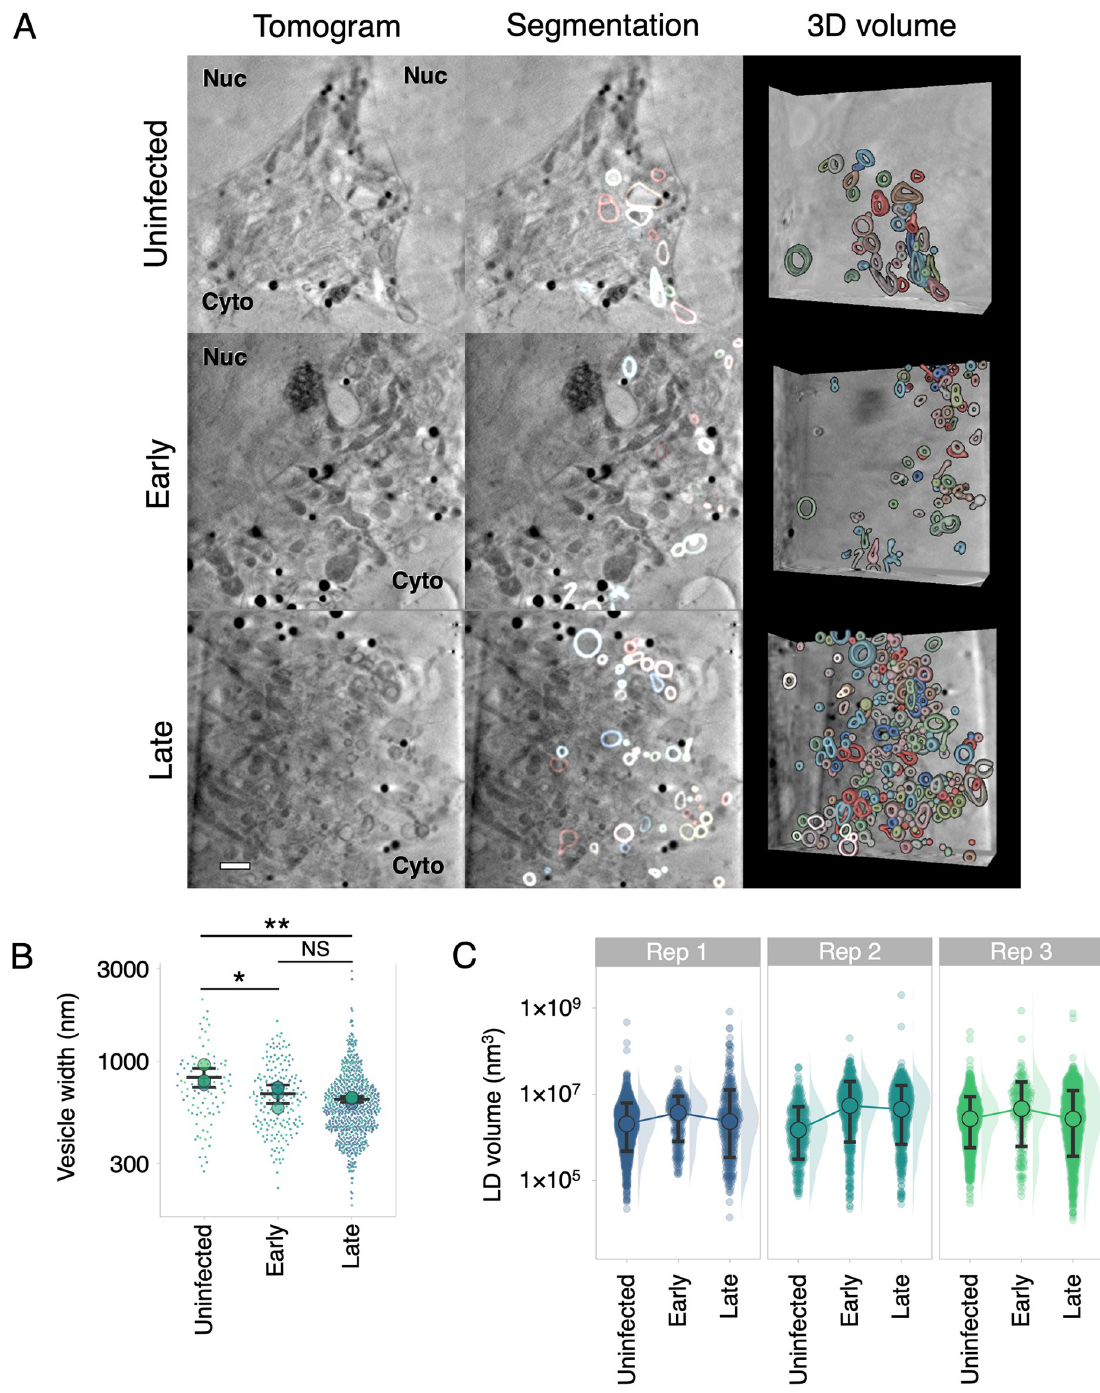
Fig 4. Remodelling of cytoplasmic vesicles during HSV-1 infection. CryoSXT tomograms were recorded from uninfected cells, or cells at an early or late stage of infection with timestamp HSV-1, as determined via wide field fluorescence cryo-microscopy. Data are representative of three independent experiments. Scale bar = 1 μ m. ( A ) A higher concentration of vesicles is observed at the juxtanuclear compartment in cells at early- or late-stages of infection compared with uninfected cells. ( B ) The maximum width of each vesicle in three- dimensions was measured in Contour [60]. Width was measured instead of volume because the segmented vesicles were open-ended owing to reduced contrast in the tomograms of membranes normal to the incident X-ray beam. Vesicles with a spherical, ellipsoidal, or dumbbell shape were included in the analysis but vesicles with a shape that didn’t fall into these categories were excluded. Intra-luminal vesicles and vesicles that were not individually resolved by the segmentation were also excluded from the analysis. Significance of